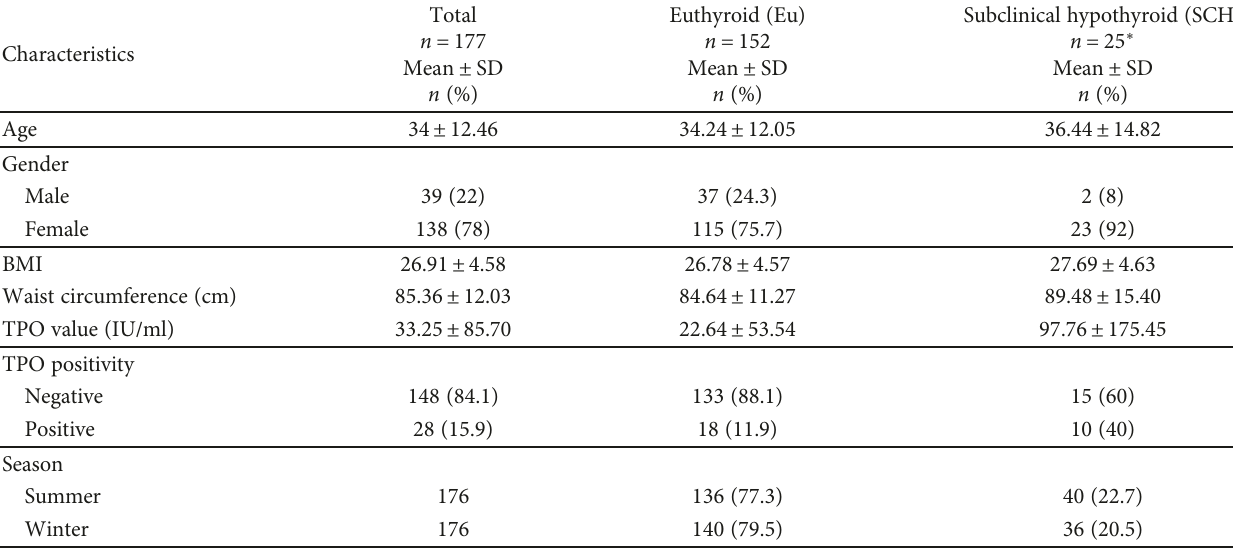
Table 2: Demographic characteristics of the study subjects.